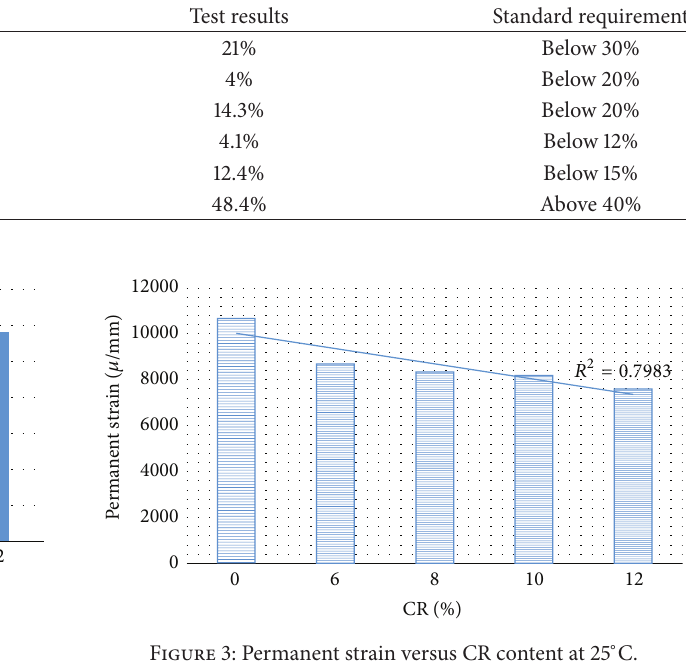
Figure 3: Permanent strain versus CR content at 25 ∘